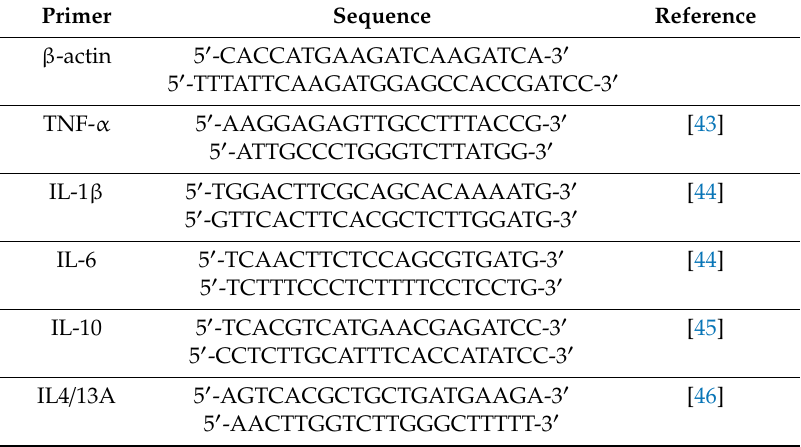
Table 2. The primers used for detecting cytokine expression in RT-PCR. Primer